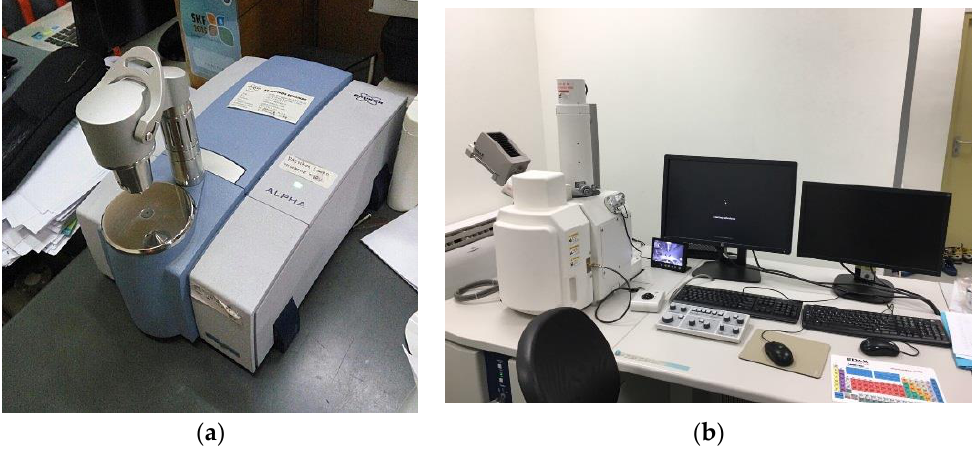
Figure 1. ( a ) ALPHA FTIR Spectrometer; ( b ) Hitachi SU 3500 and EDAX.